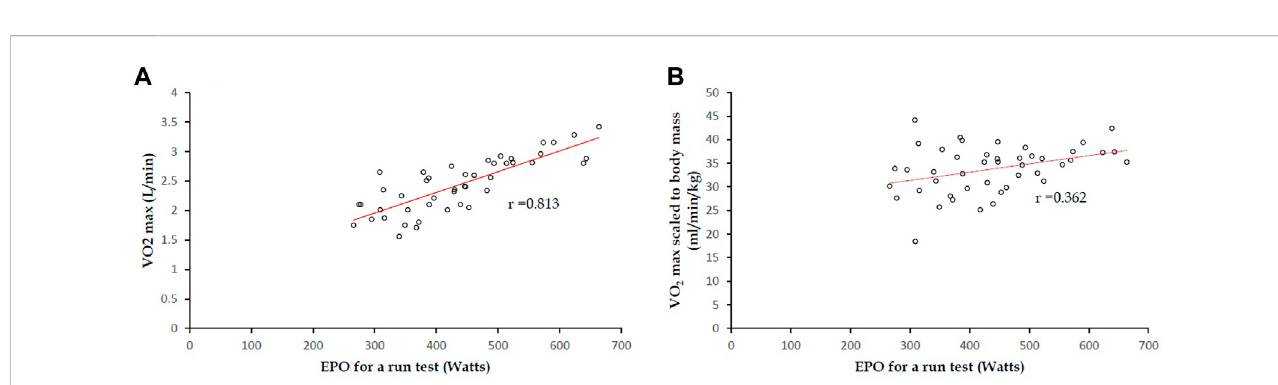
FIGURE 3 In 45 participants, for both a 3,000-m run fi eld test and CPET: (A) correlation coef fi cient of EPO for a 3000-m run fi eld test against VO 2 max (L/min) was 0.813 ( p < 0.001); (B) correlation coef fi cient between EPO for a 3,000-m run fi eld test and VO 2 max scaled to body mass (kg) was estimated to be 0.364 ( p <